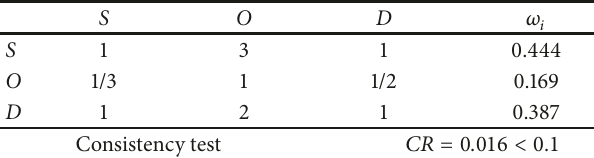
Table 5: Weight distribution of S , O , and D .